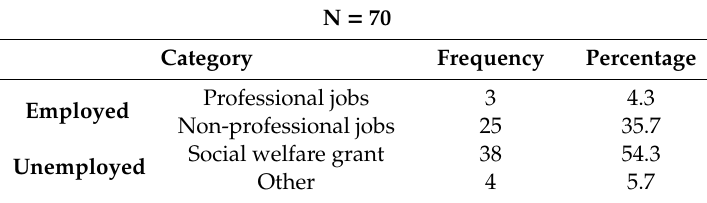
Table 2. Level of employment in the Makwane community during the study